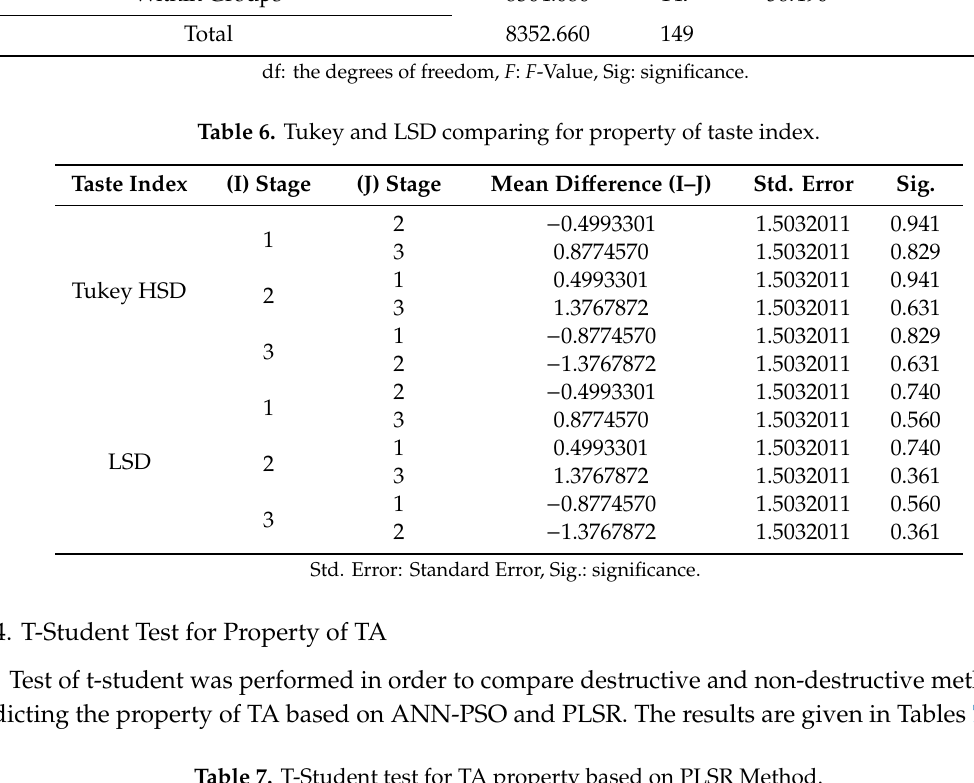
Table 7. T-Student test for TA property based on PLSR Method.